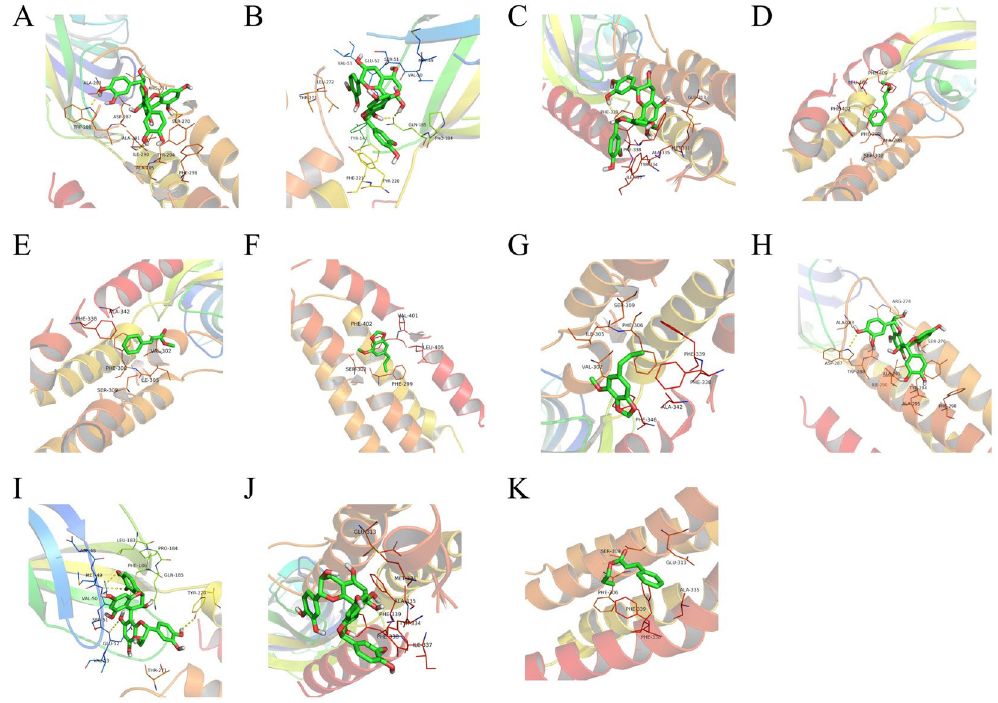
Figure 9. 3D docking of the active ingredient (ligand) of cinnamon aqueous extract against AD-related GABAergic synaptic dysfunction targets (receptors) ( A - K ) The binding effect of ligand and receptor are shown.